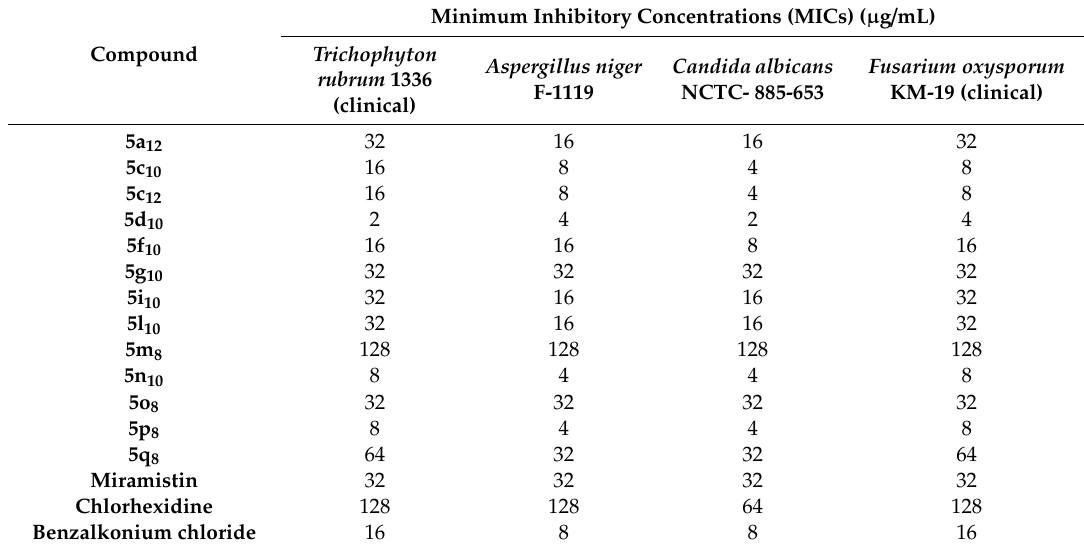
Table 3. In vitro antifungal activity of novel bis-ammonium salts of pyridoxine.